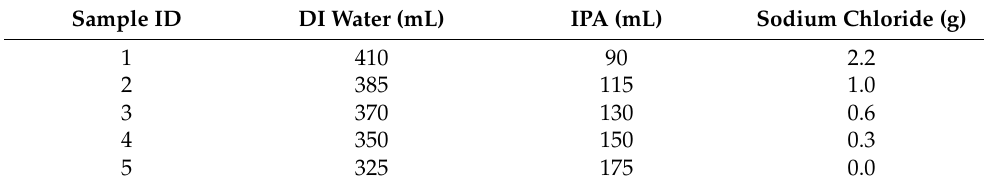
Figure 5. Measured values of electrical conductivity.